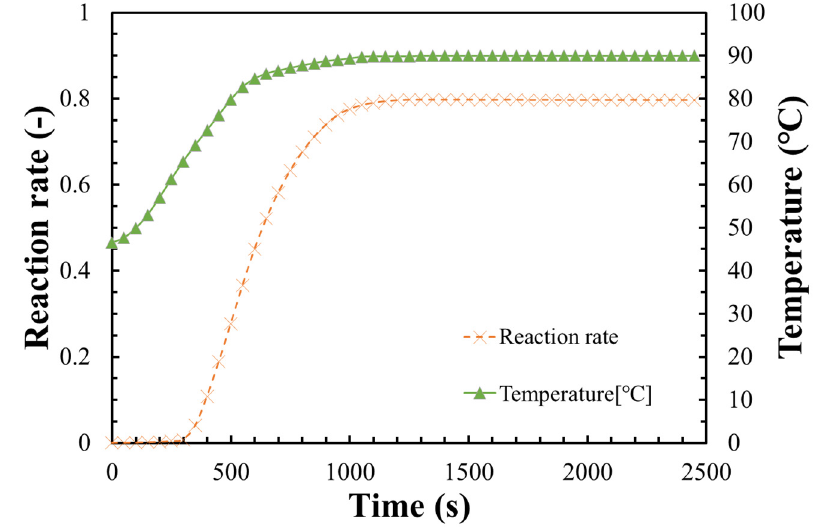
Figure 10. Dehydration reaction rate of LiOH • H 2 O.